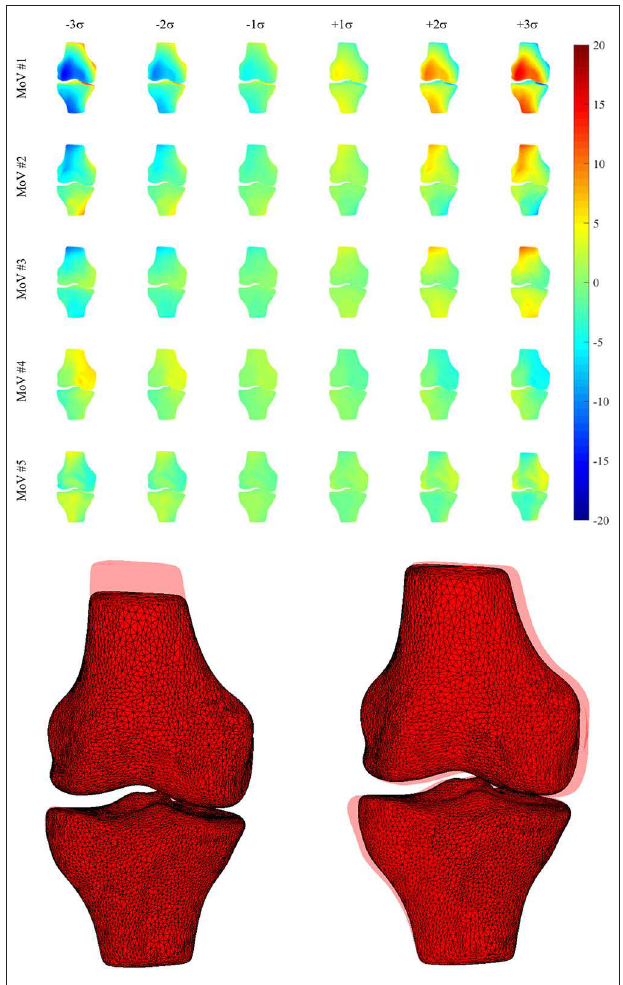
FIGURE 3 | (Upper) Morphological deviations (mm) from the mean model (frontal view) for MoVs from #1 to #5. (Lower) Explicit morphology in two SSM parameter sets (MoV #3 -3 σ , MoV #4 +3 σ ) with the overlaid mean model.